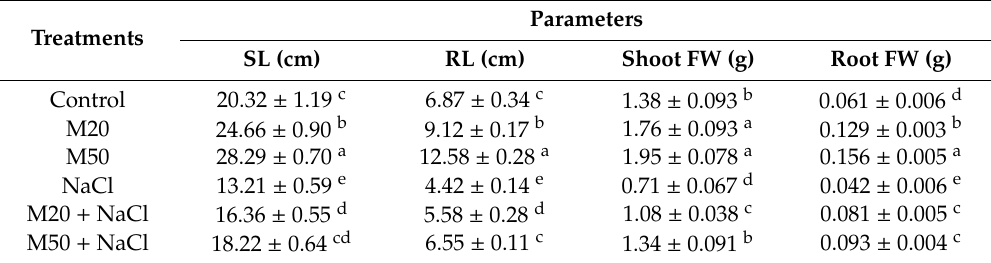
Table 1. E ff ect of melatonin on shoot length (SL), root length (RL), shoot fresh weight (shoot FW)